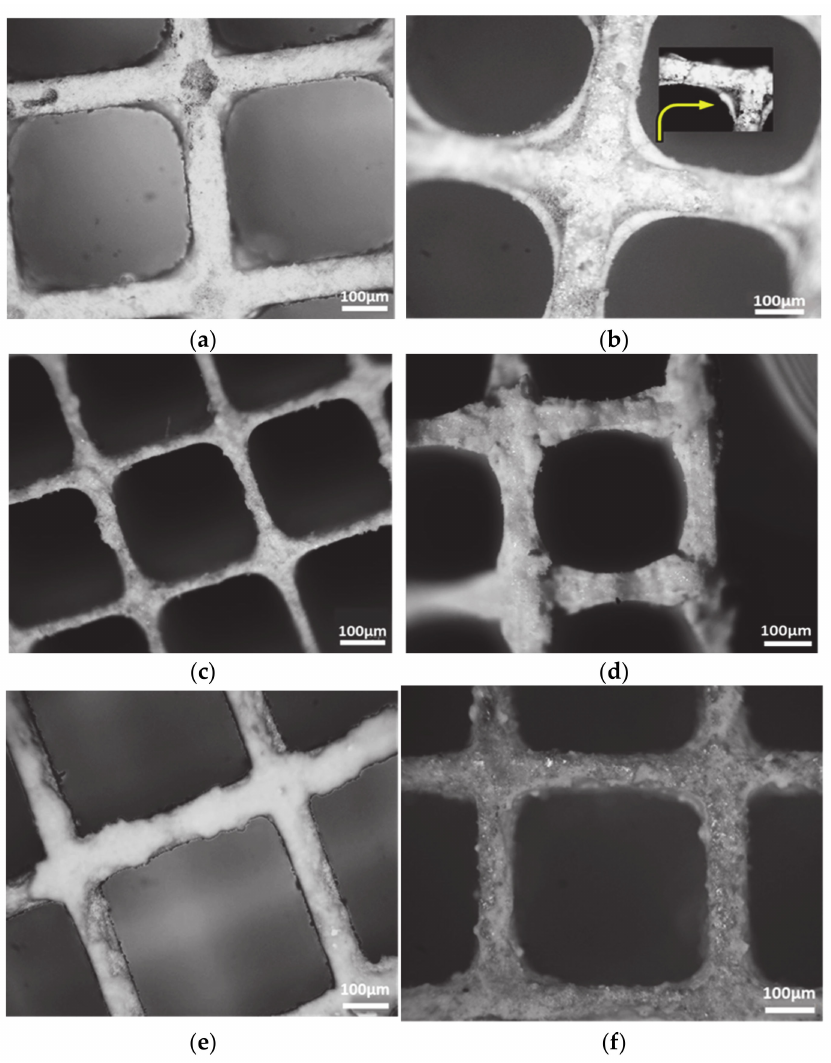
Figure 5. Optical microscopy cross-section images (5 × ) of the catalysts: ( a ) OEM III; ( b ) OEM V/VI (inlet image 10 × ); ( c ) Primary catalyst of OEM V/VI; ( d ) Second catalyst of OEM V/VI; ( e ) 5PROM2; ( f )